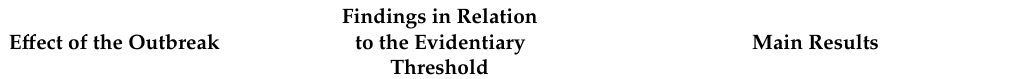
Table 1. Outbreaks providing evidence of aerial transmission of